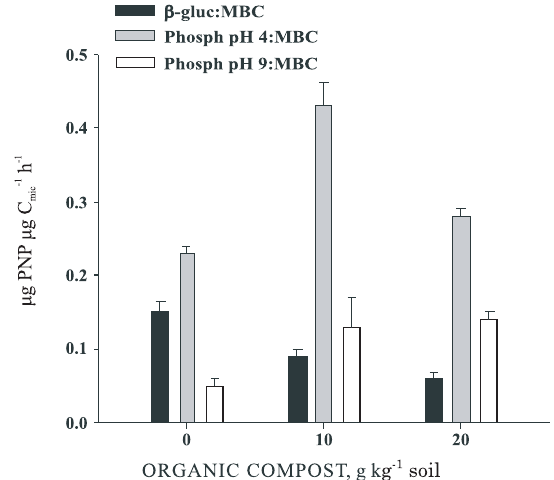
Figure 4. Ratio of enzyme activity to microbial biomass carbon (MBC): βββββ -gluc:MBC ( βββββ - glucosidase activity/MBC), Phosph ph4:MBC (Acid phosophotase activity/MBC) and Phosph ph9:MBC (Alkaline phosphatase activity/MBC). PNP: ρρρρρ -nitrophenol. Vertical bars indicate average confidence intervals at 5% probability